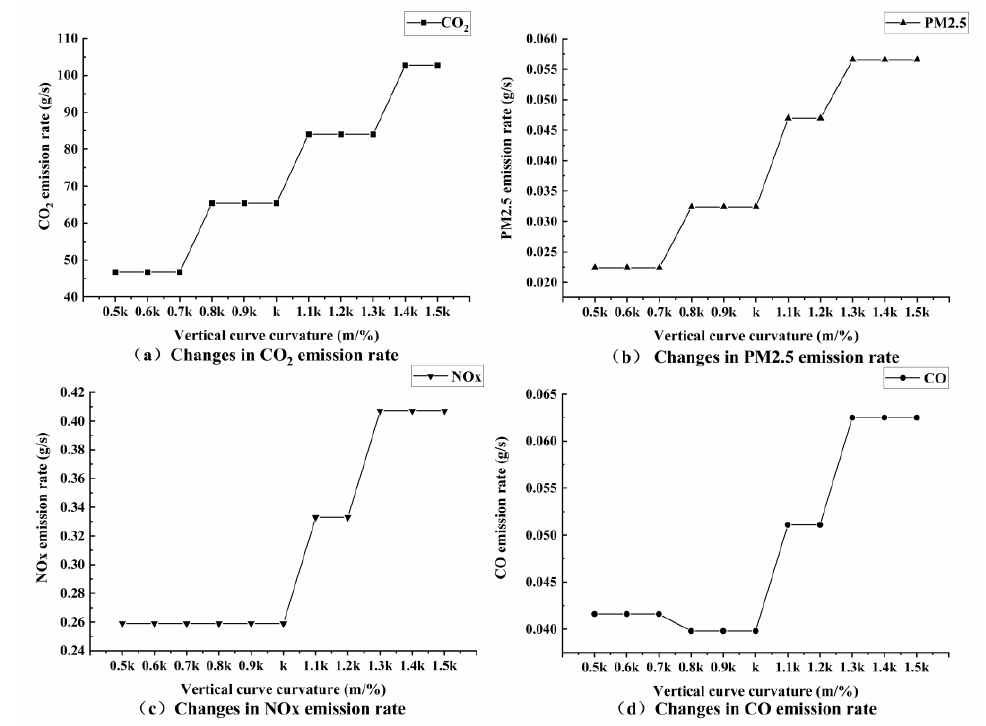
Figure 7. Exhausts emission rate of crest vertical curve section: ( a ) Changes in CO 2 emission rate; ( b ) Changes in PM 2.5 emission rate; ( c ) Changes in NO x emission rate; ( d ) Changes in CO emission rate.